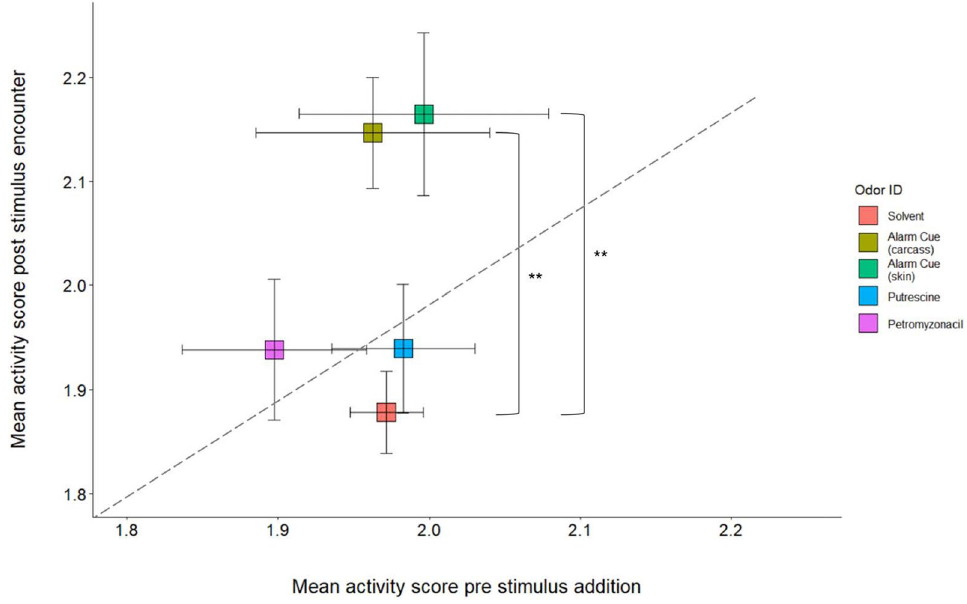
Figure 3. Mean (± 1SE) activity score before addition of odorants by mean (± 1SE) activity score after encounter with odorant. Responses to odors with an asterisk represent a significantly different change in activity (* p < 0.05; ** p < 0.01; *** p < 0.001) based on Tukey HSD. The dashed line represents the null hypothesis of no change in activity before and after stimulus exposure. Responses above the line indicate an increase in activity post exposure to the odor, and responses below the line indicate a decrease in activity post exposure to the odor. The minimum score possible is 1 (indicating the entire trial period was spent on low activity behaviors per the ethogram in Table 1) and maximum is 3 (indicating the entire trial period was spent on high activity behavior per the ethogram in Table